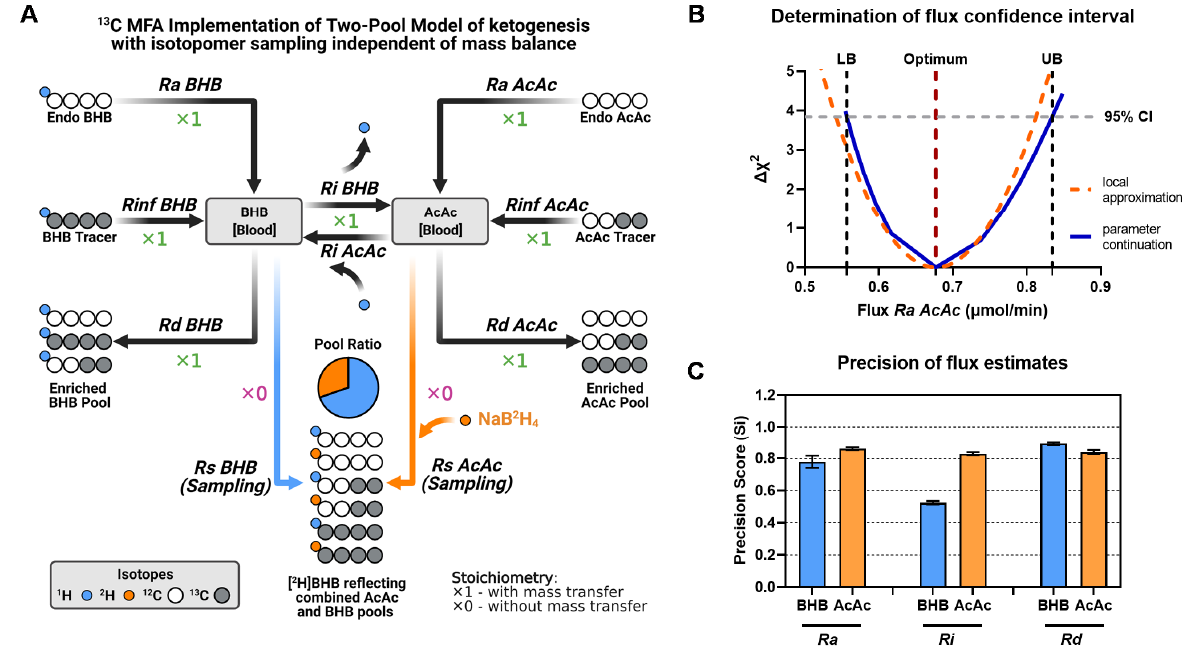
Figure 7. A novel MFA implementation of the two-pool model of ketogenesis. ( A ) Isotopomer model structure. Note that additional sampling reactions ( Rs ) for BHB and AcAc have a stoichiometric coefficient of 0 to access labeling information but prevent the reaction from being part of the mass balance network. Unlike the matrix method, the MFA model encodes the BHB and AcAc pool ratio, although steady-state flux estimates are independent of this information. ( B ) Determination of confidence intervals (CI) for Ra AcAc . The MFA version of the two-pool model of ketogenesis allows determination of individual CIs by calculating lower (LB) and upper (UB) boundaries. ( C ) Precision of flux estimates. Precision scores were determined based on the normalized range of confidence intervals across all samples used for the model development. Precision scores were calculated for fluxes estimated in 14-week-old mice that were fasted for 18-h (see Figure 3).